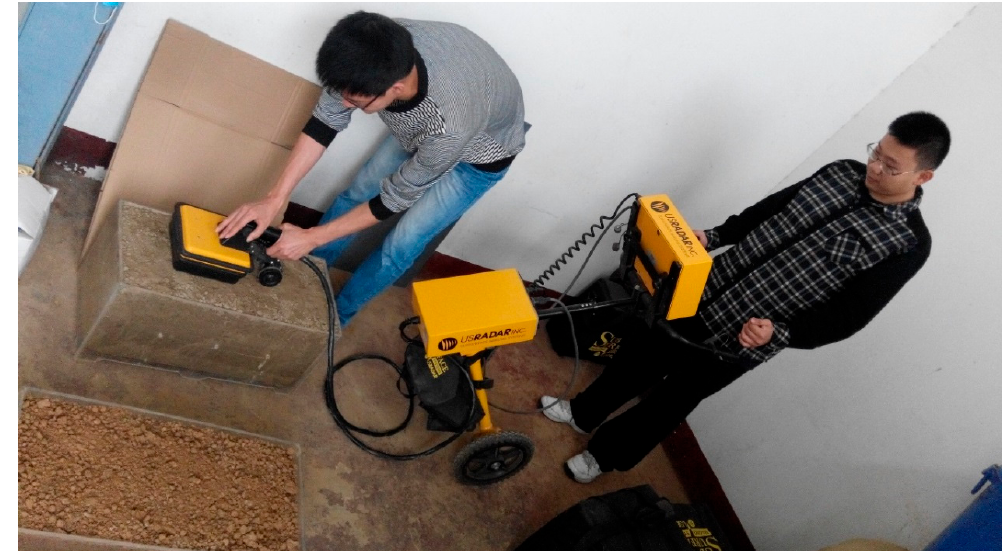
Figure 4. GPR measurement in the laboratory box. Table 2. GPR parameters.